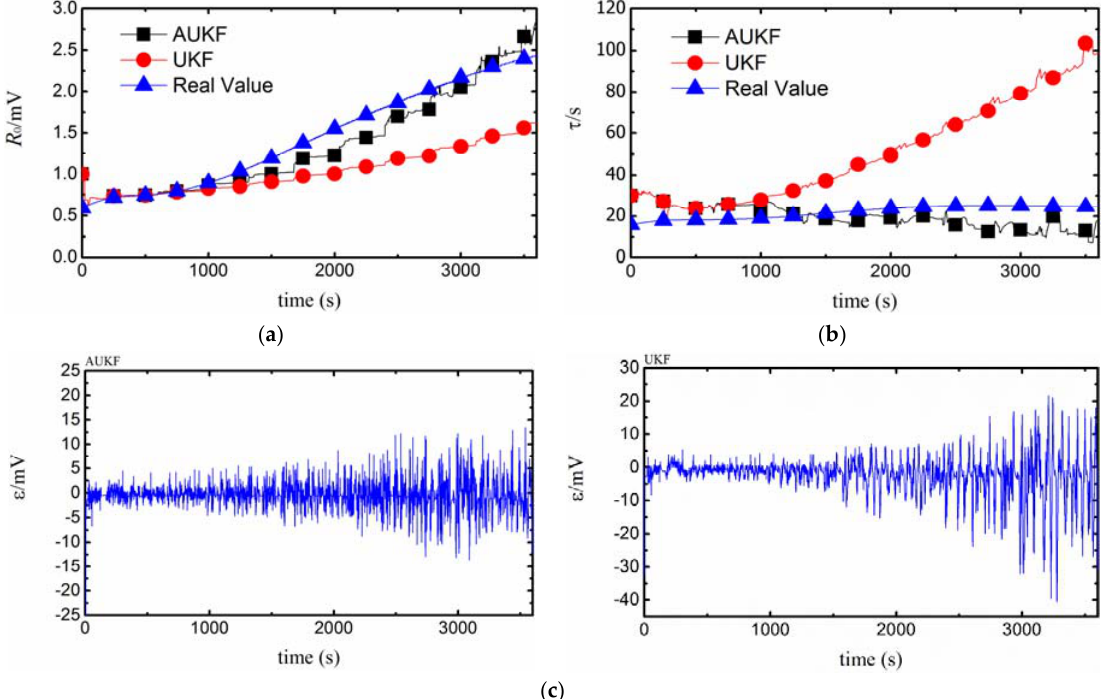
Figure 8. Estimation results of parameter slow-varying type fault. ( a ) Comparison of Ohmic resistance estimation; ( b ) Comparison of time constant estimation; ( c ) Comparison of voltage residual.